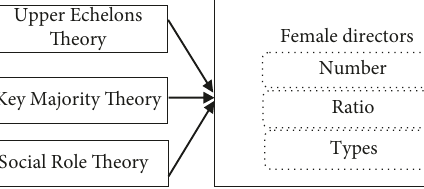
Figure 1: A theoretical model of the influence of FDs on